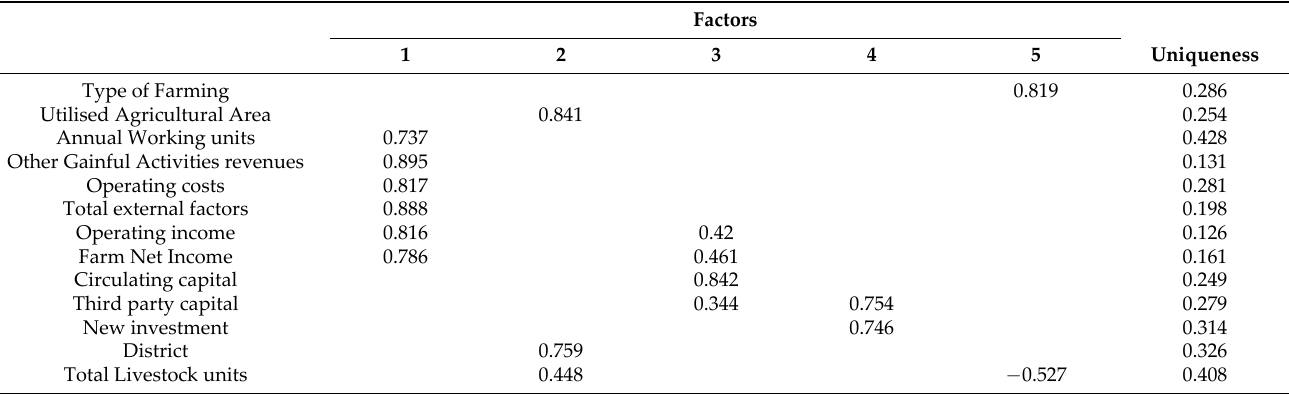
Table 4. Results of principal component